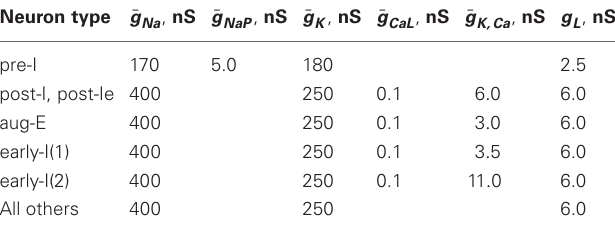
Table A2 | Maximal conductances of ionic channels in different neuron